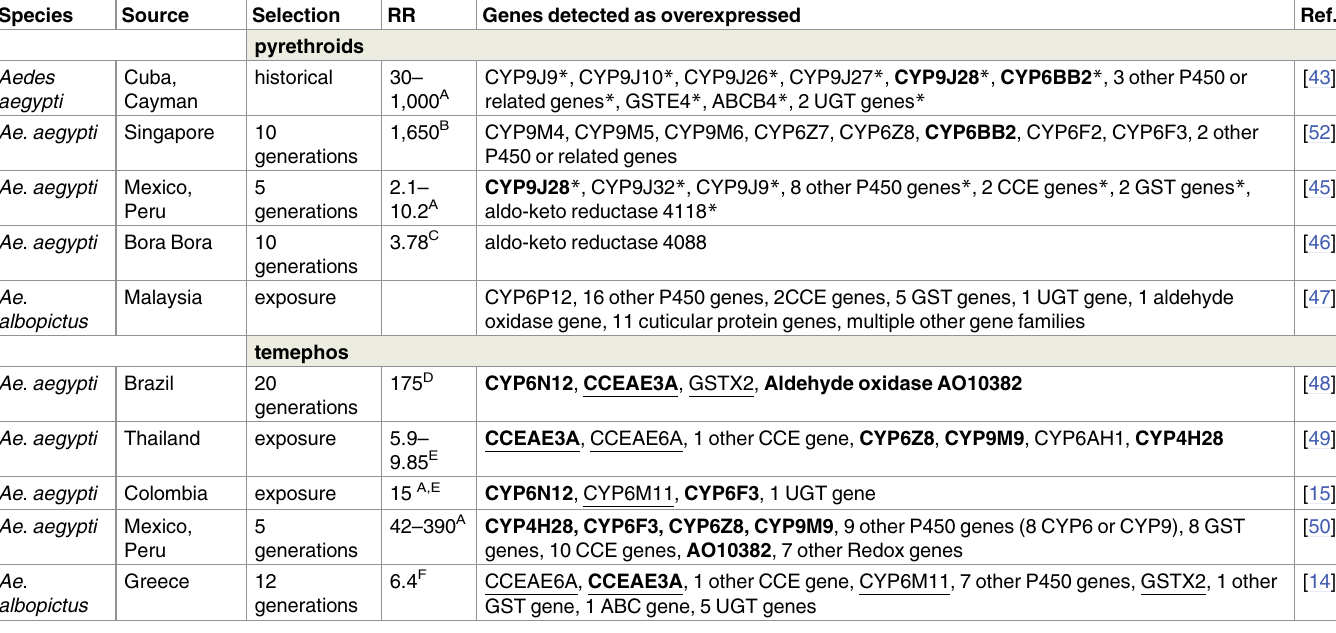
Table 2. The main genes identified by transcriptomic studies specifically targeting expressionresponses to insecticide selection or exposure.